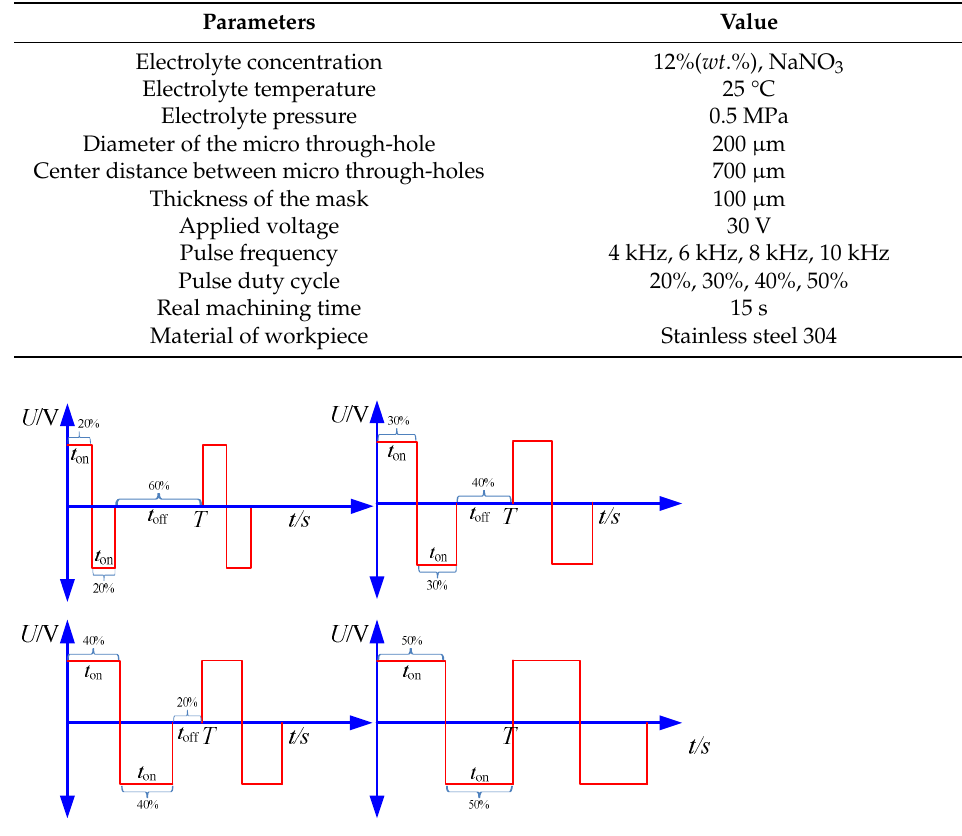
Figure 8. The schematic diagram of bidirectional pulse with different pulse duty cycles.